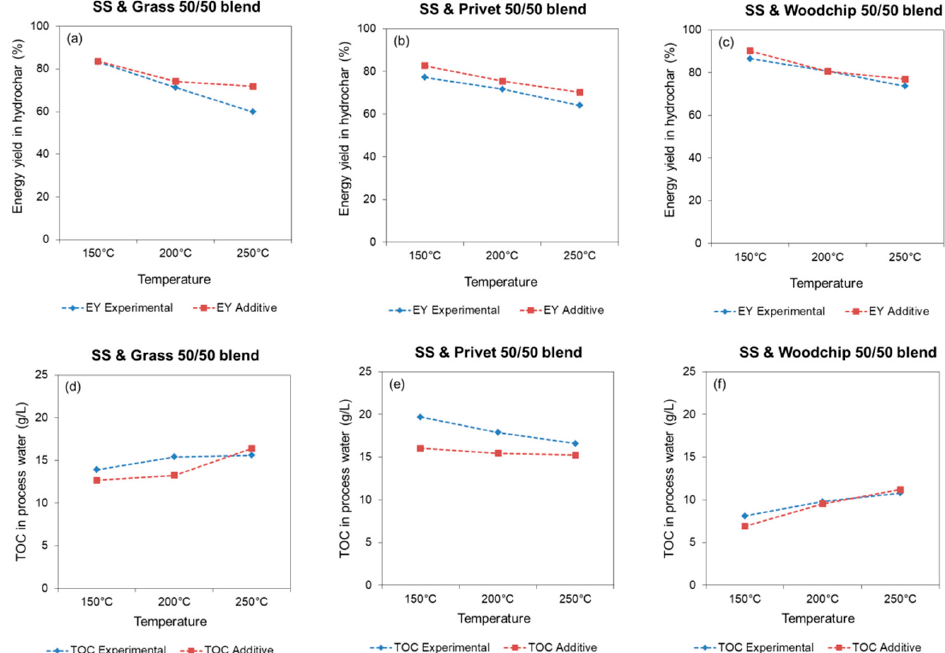
Figure 5. Comparison of experimental and additive levels in the hydrochar of ( a ) EY for SS and grass at 50/50 blend, ( b ) EY for SS and privet hedge at 50/50 blend, ( c ) EY for SS and woodchip at 50/50 blend, ( d ) process water TOC for SS and grass 50/50 blend, ( e ) process water TOC for SS and privet hedge for 50/50 blend, and ( f ) process water TOC for SS and woodchip for 50/50 blend.